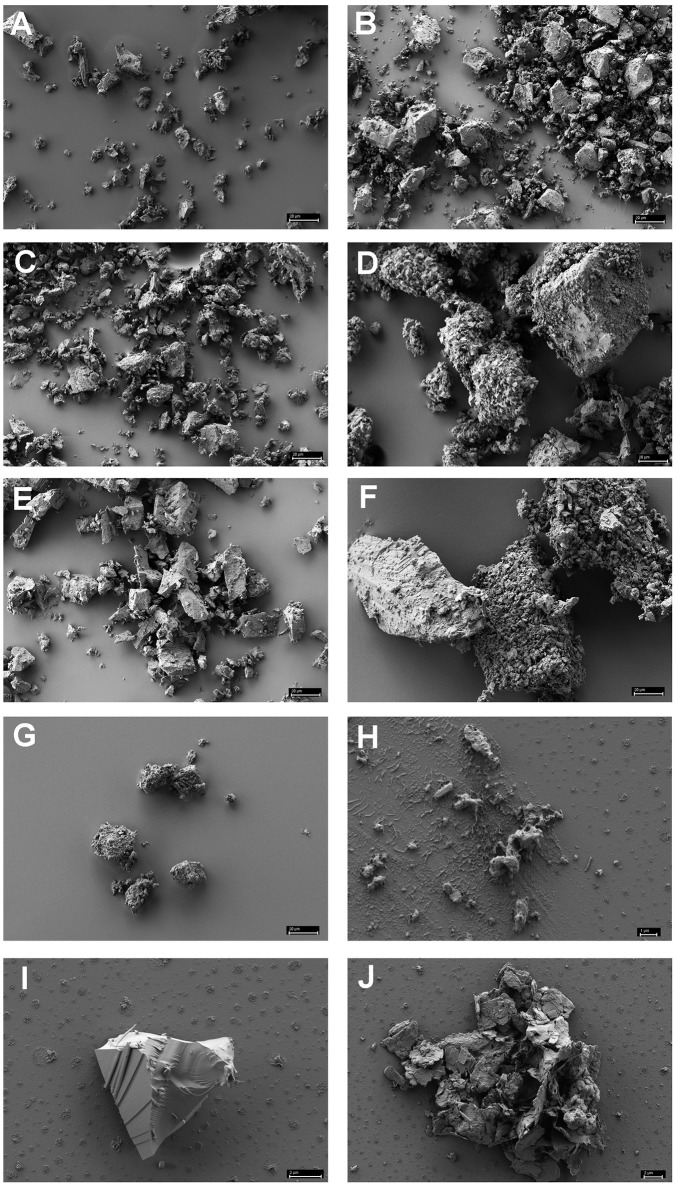
Scanning electron microscopy of various minerals reported to be often found in black smokers (A–G) and of authentic black smoker material (H–J). (A) chalcopyrite; (B) hematite; (C) chalcosine; (D) pyrite; (E) sphalerite; (F) pyrite + sphalerite (1:1 in weight); (G) wurztite; (H) authentic BSM of the grainy, amorphous type a; (I): authentic BSM with regular surface, type c; (J): authentic BSM of the unstructured type b. Size bars in (A–G) 20 μm; in (H) 1 μm; in (I,J) 2 μm.